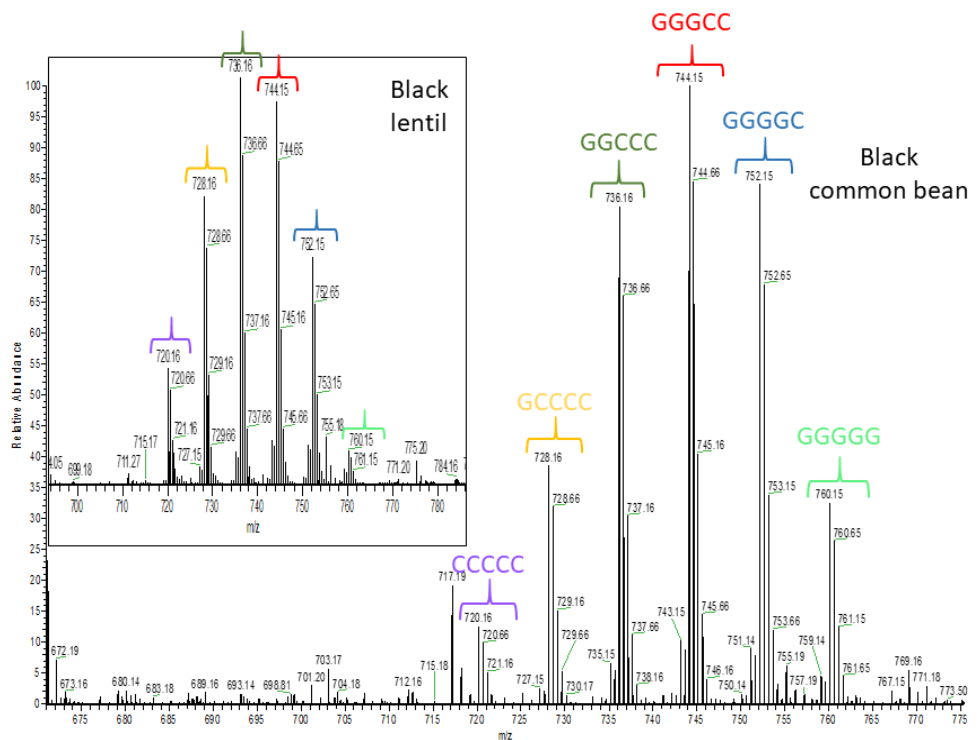
Figure 7. High resolution mass spectrometric (HRMS) full scan showing a procyanidin pentamer and different prodelphinidin pentamers detected in black common bean and lentil seed coats. Brackets with the same color have the same pentamer structure. C: (epi)catechin and G: (epi)gallocatechin.